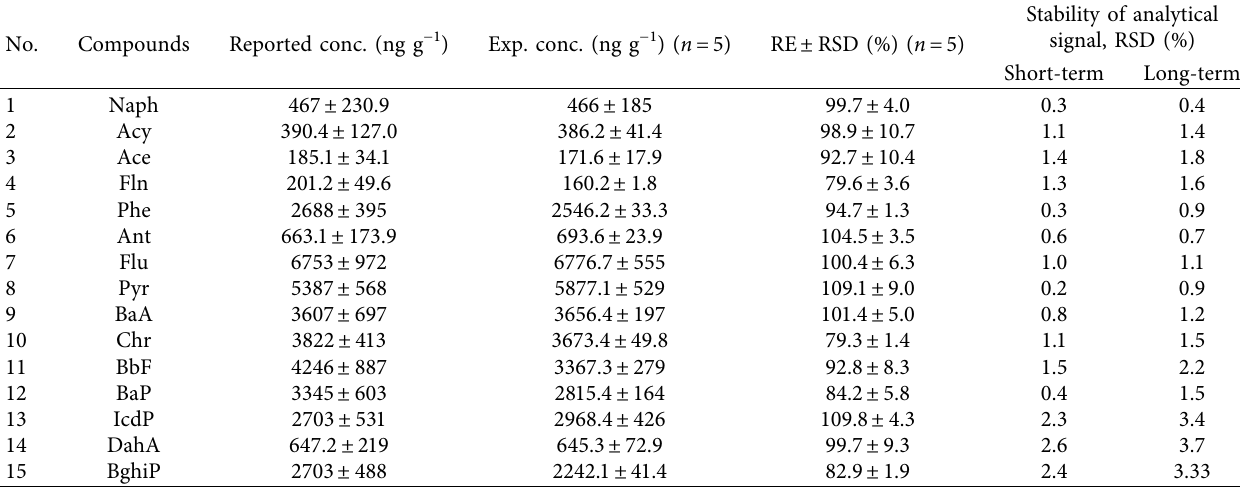
Table 3: Proficiency testing sample based recovery and stability of analytical signal in GC-EI-MS/MS analysis of PAHs.